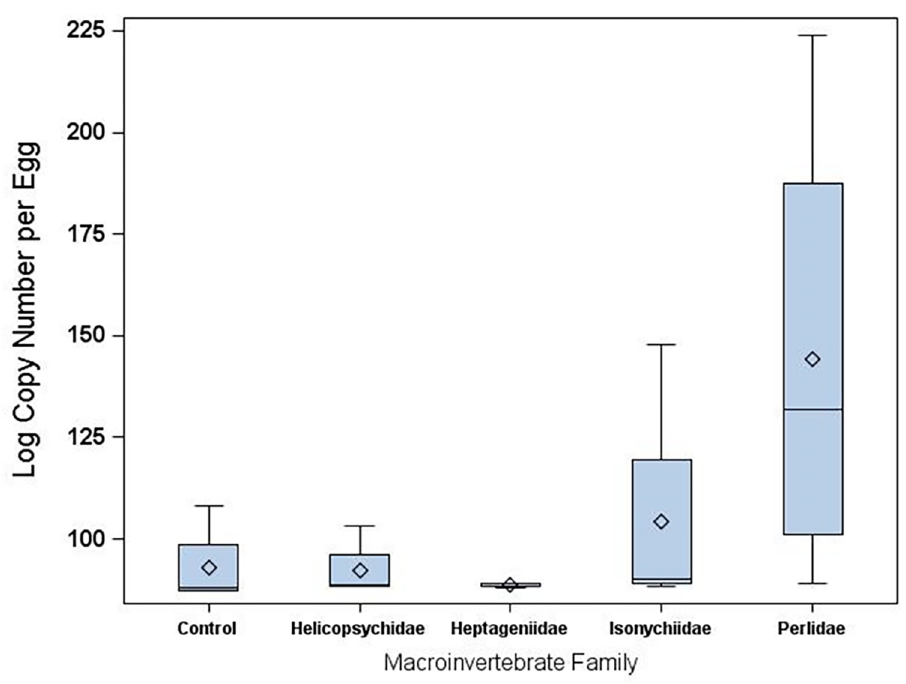
Fig 4. Quantitative PCR analyses of bacterial (16S) abundance for lake sturgeon egg surface communities sampled from each aquatic insect treatment during time 2 (4 da post fertilization).